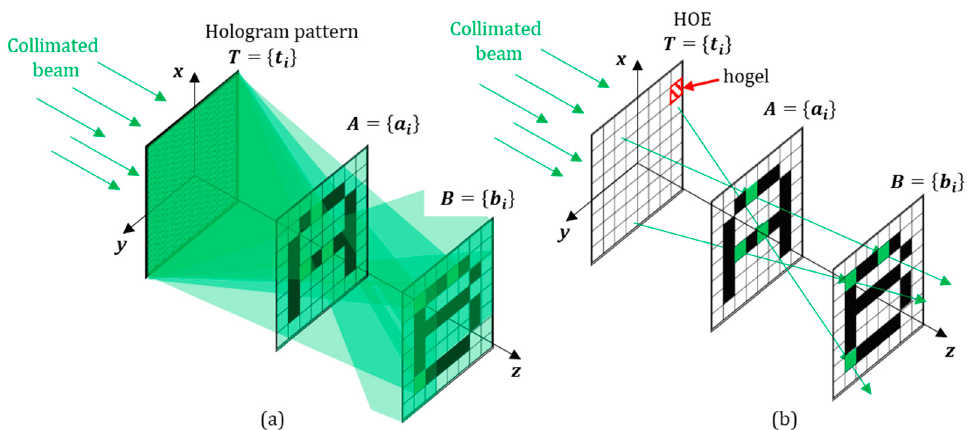
Figure 1. Conceptual scheme for holographic projections; ( a ) using conventional holographic projection and ( b ) the proposed speckle noise ‐ free holographic projection.